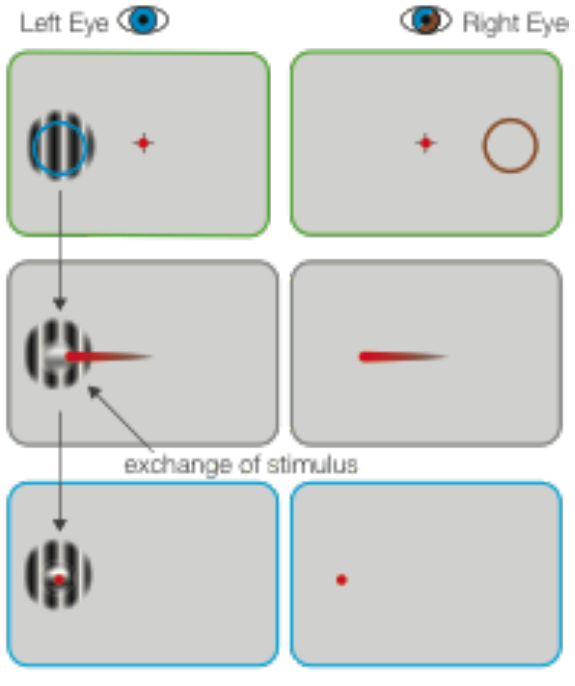
Figure 6. Experimental design for the investigation of violation of expectations based on sampled evidence vs. inference. Each set of two panels shows the stimulus presented to the left and the right eye, respectively. After a fixation interval, a stimulus appeared monocularly in the periphery (top). After the disappearance of the fixated crosshair, the subjects perform a saccade to the center of the presaccadic stimulus (middle). In this example, contingent on the gaze position the central part of